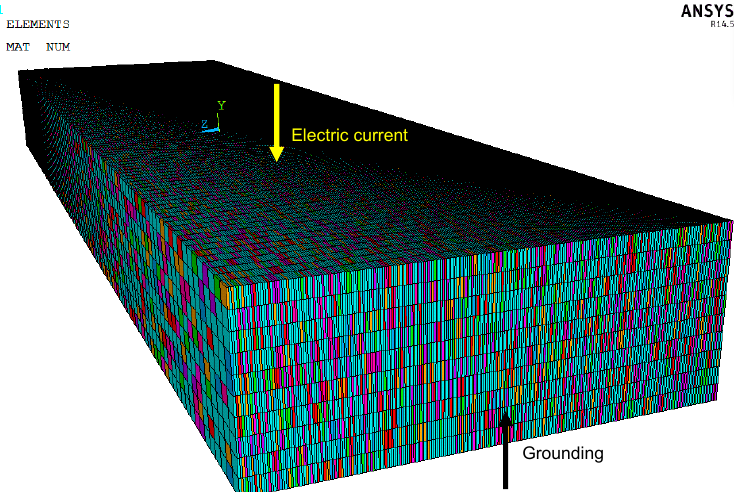
Figure 4. FE mesh of the macro-scale model.